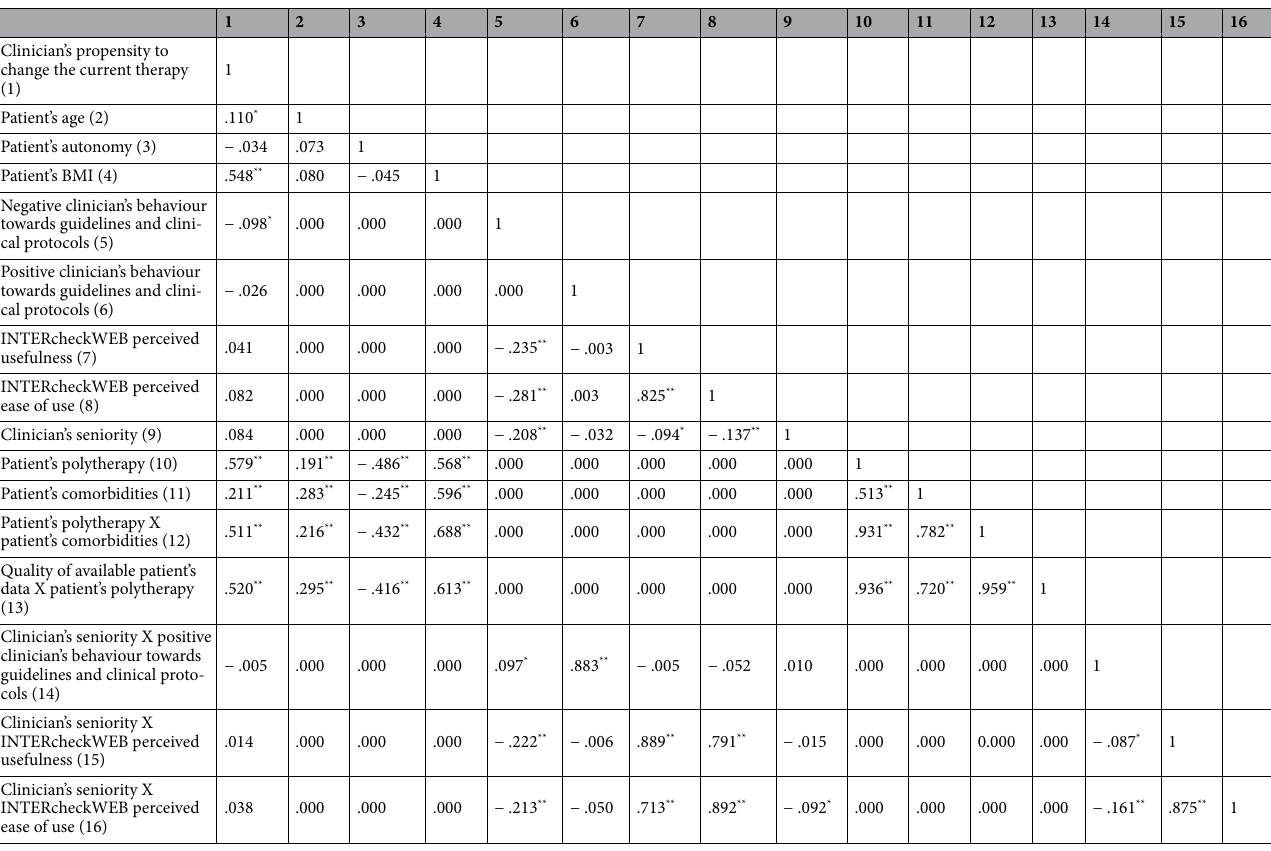
Table 1. Relationships among variables. *p-value > 0.05; ** p-value >